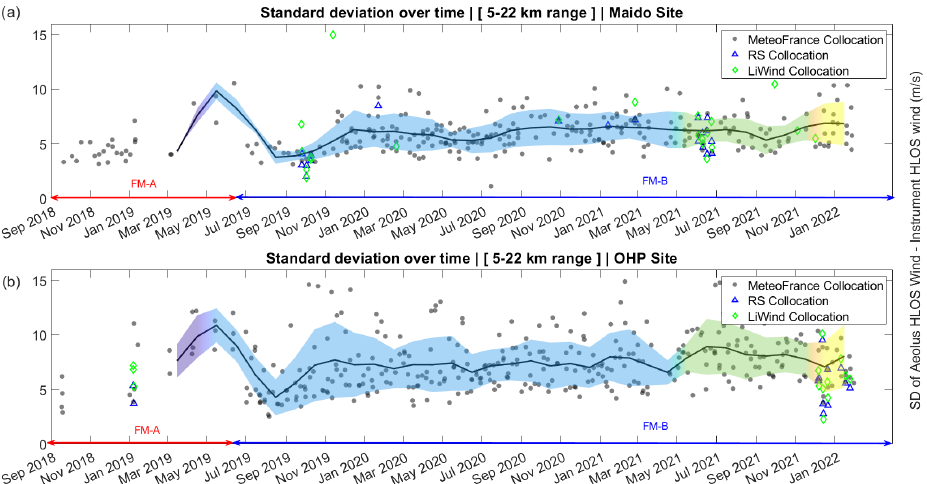
Figure 6. Standard deviation of the difference between Aeolus Rayleigh clear HLOS wind and Météo-France Radiosonde HLOS wind over time (a) at the Maido observatory and (b) at the Observatoire de Haute-Provence. The Météo-France data were downsampled to Aeolus vertical resolution and projected to the HLOS of Aeolus. For radiosonde and ground-based lidar collocations, the cal/val punctual collocations are reported in the figure in blue and green markings. The black line represents the average value, and the shading represents its standard deviation. The colors are relative to the four baselines used: 2B02 (violet), 2B11 (blue), 2B12 (green), and 2B13 (yellow), in that